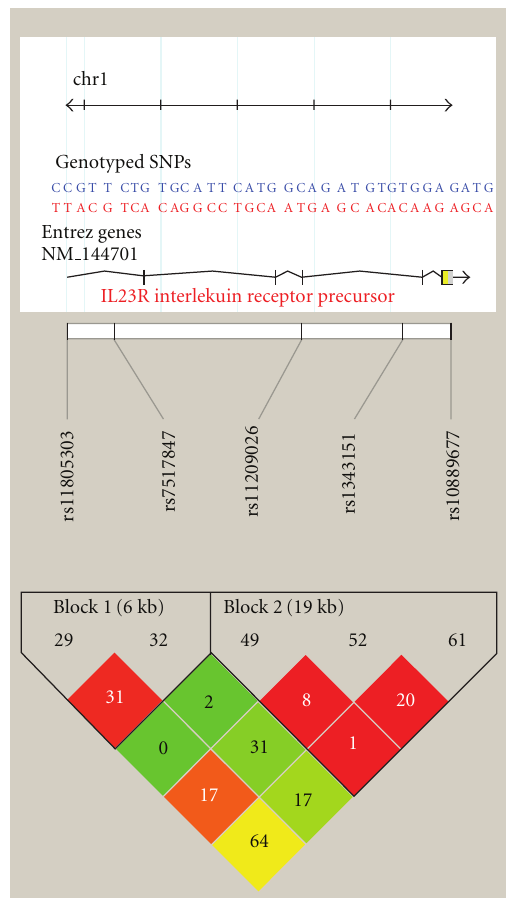
Figure 1: IL23R LD